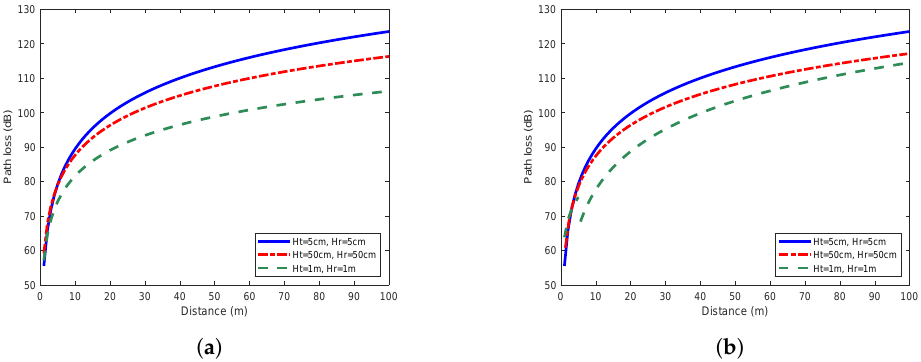
Figure 5. Path loss models under the flat grass scenario: ( a ) one-slope model; and ( b ) two-slope